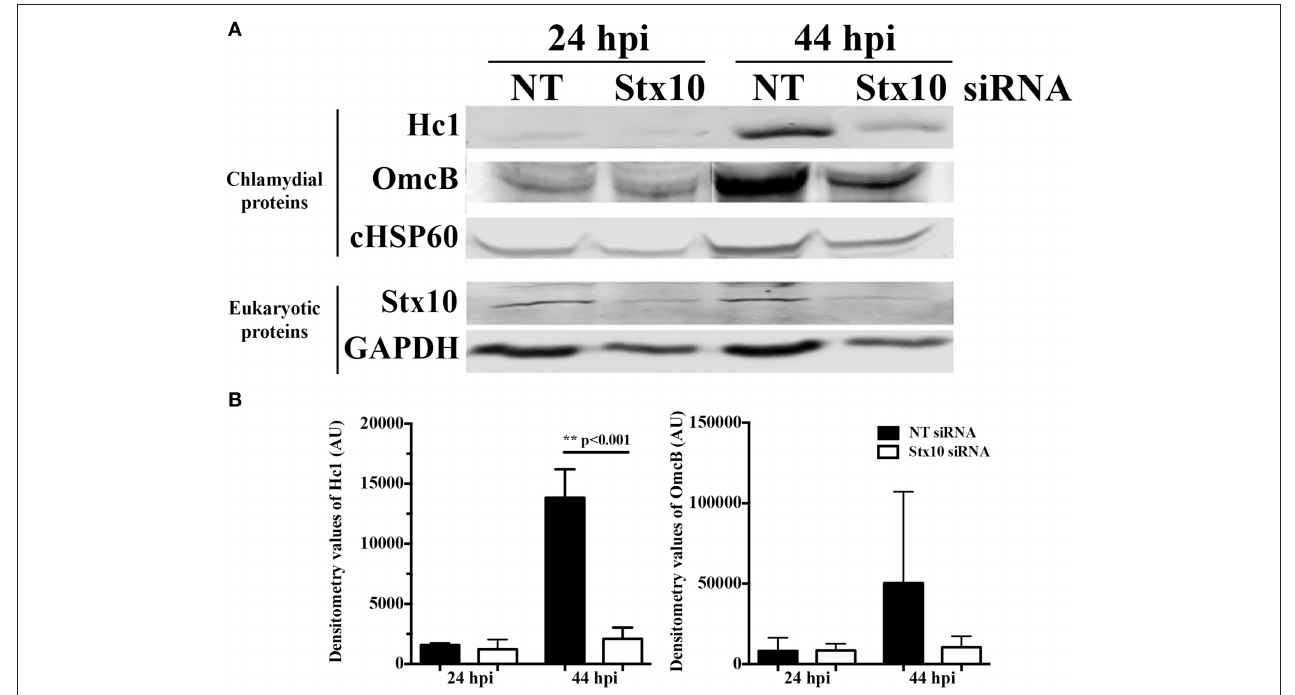
FIGURE 3 | Effect of siRNA knockdown of syntaxin 10 on expression of late chlamydial proteins: Hc1 and OmcB. Syntaxin 10 or non-targeting (NT) siRNA-treated HeLa cells were infected with C. trachomatis serovar L2 for 24 or 44h, prior to lysis in Laemmli sample buffer. (A) Equal amounts of protein were loaded onto SDS-PAGE gels and transferred prior to Western blot analysis using antibodies against chlamydial proteins Hc1, OmcB or chlamydial heat shock protein 60 (cHSP60) or eukaryotic proteins syntaxin 10 and GAPDH. The Western images shown are representative of two independent experiments. (B) Densitometry analysis was performed on the two independent experiments referred to in (A) . These values [expressed in arbitrary units (AU)] were obtained using the Image Studio imaging software associated with the LI-COR Odyssey Infrared Imaging System and then graphed as mean and standard error of the mean. Statistical analysis included an ordinary One-Way ANOVA with Tukey’s multiple comparison test in GraphPad Prism 6